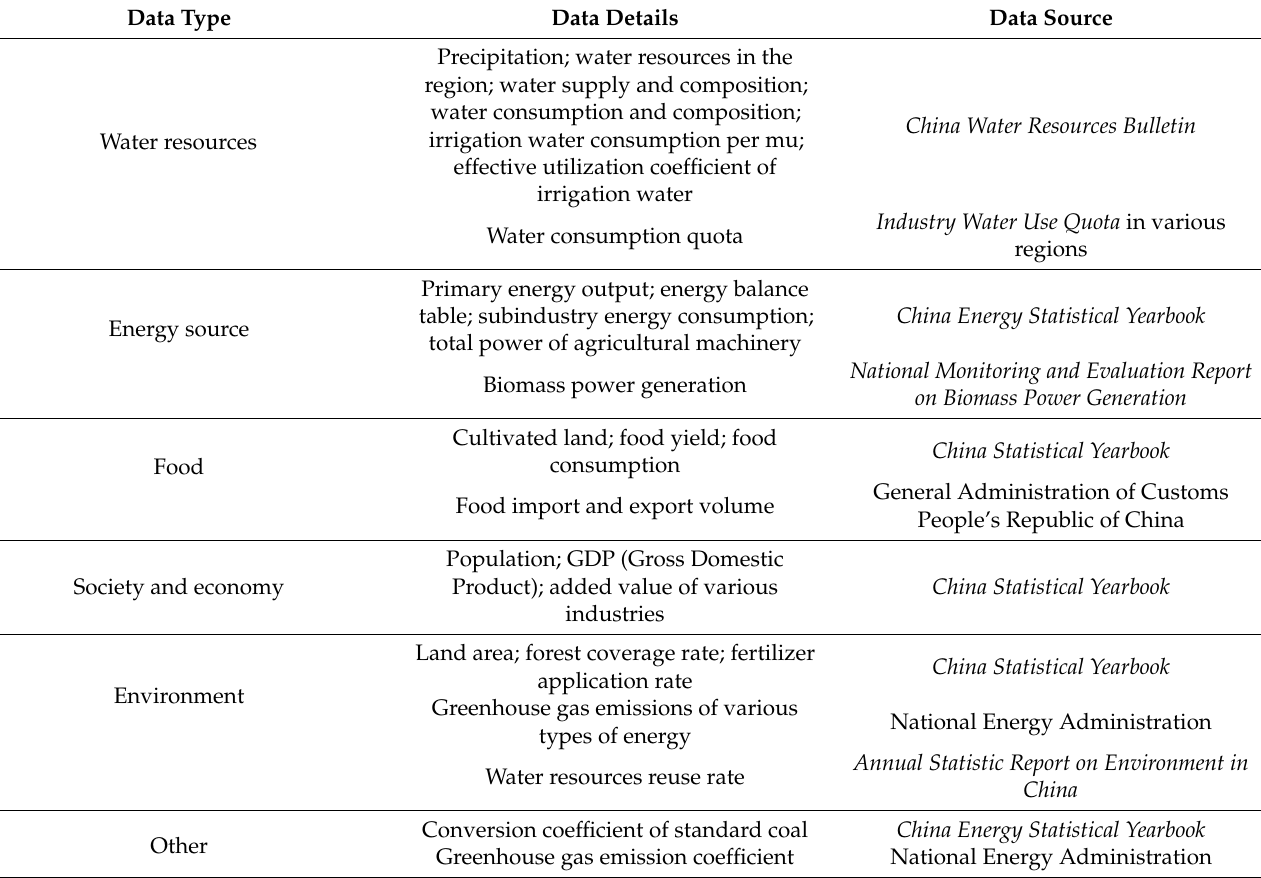
Table 1. Description of the data used in our study.